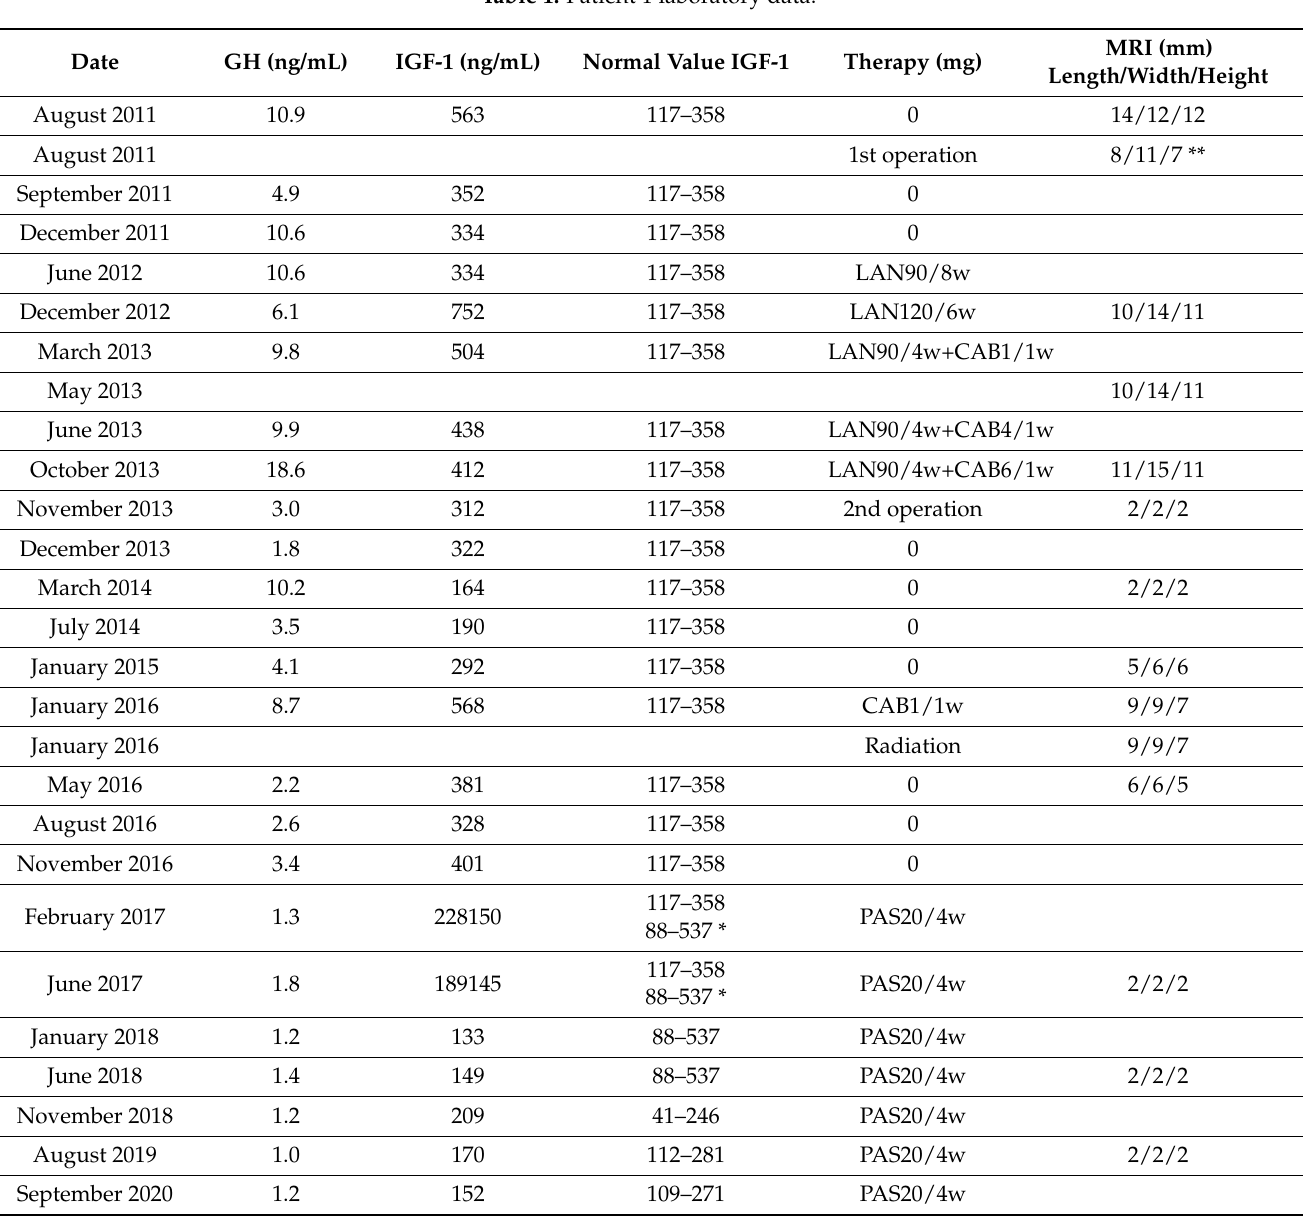
Table 1. Patient 1 laboratory